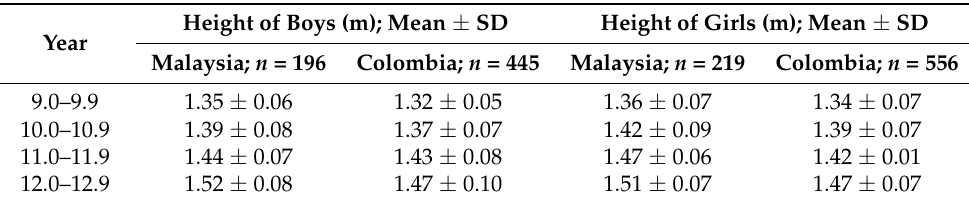
Table A1. Comparison of mean height for schoolchildren from Malaysia (present study) and Colom- bia by sex and